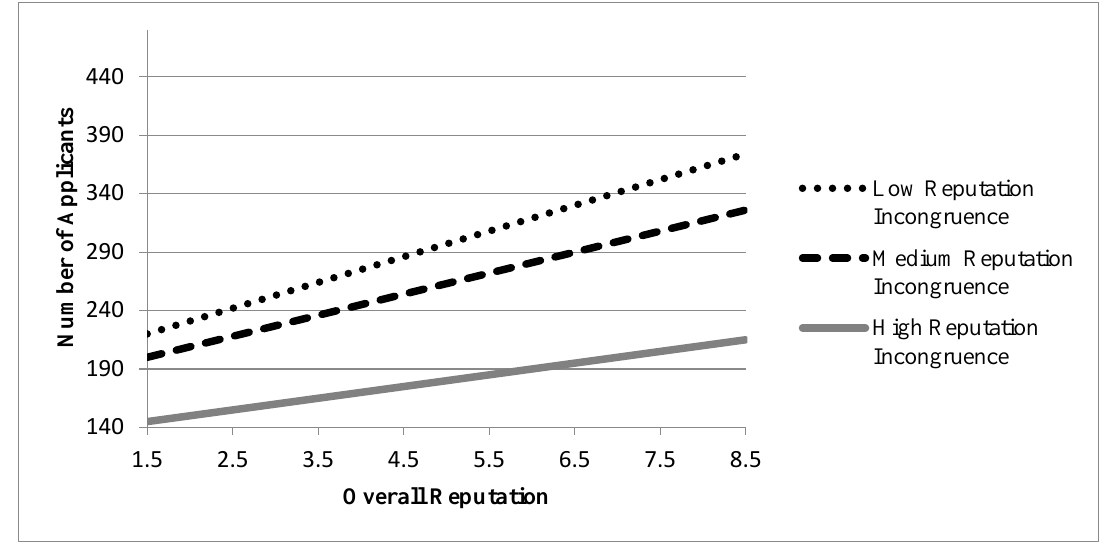
Figure 1. Moderating effect of reputation incongruence in Model 2-2. Note: High/Low groups were determined by cases outside 1 S.D.; Medium group was determined by cases within 1 S.D.